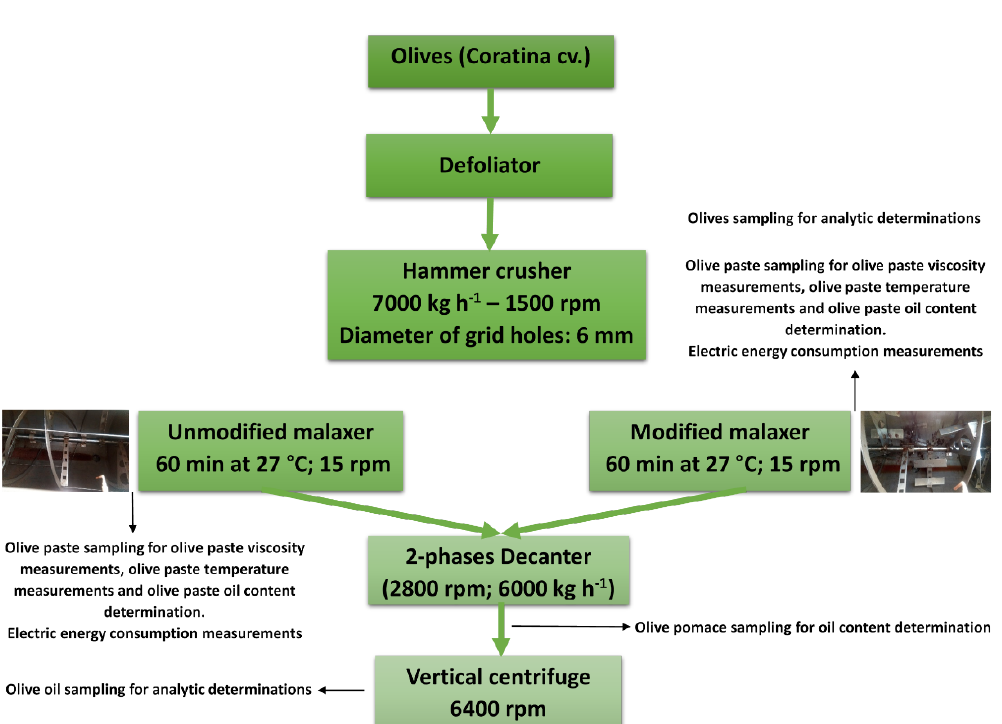
Figure 4. Flow chart of the production process and samples taken.